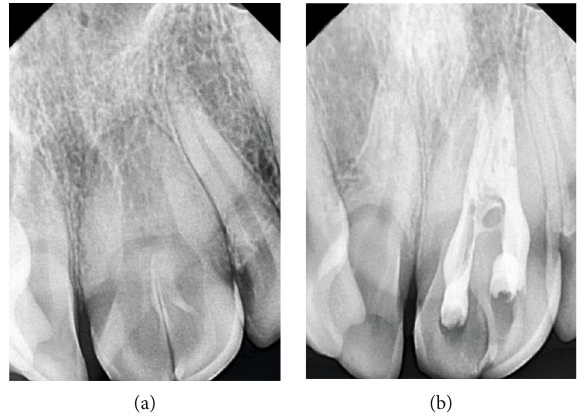
Figure 2: (a) Initial radiograph of tooth #21 before the endodontic intervention. (b) Radiograph of tooth #21 after the endodontic treatment, with the set of the 3mm apical plugs of MTA.